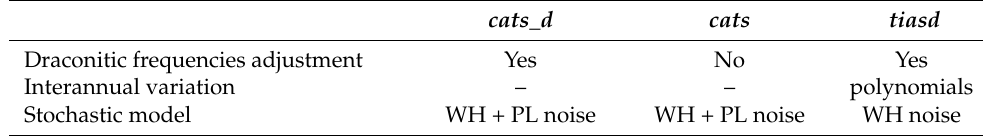
Table 2. Estimation properties of the three models considered in this article.